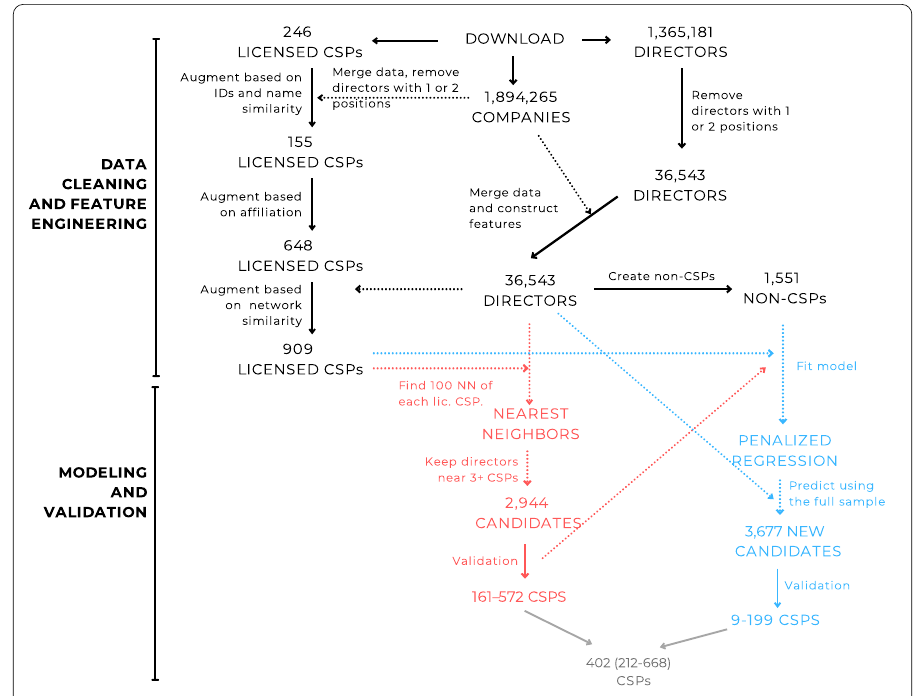
Figure 2 Flowchart with our approach, consisting of two phases. (i) The data cleaning and feature engineering phase (top part, in black). We started by downloading the datasets on licensed CSPs, companies, and directors. Directors (right branch) with one or two positions are excluded, and the remaining 36,543 directors are merged with company data to construct the network features. Licensed CSPs (left branch) are augmented using company data to reach a final set of 909 licensed CSPs. (ii) The modeling and validation phase (bottom part, in color). First, we use the nearest neighbors algorithm to find similar directors to the 909 licensed CSPs (red branch). We kept all directors that were within the 100 closest directors to at least three licensed CSPs. We manually validated 100 of them to estimate the size of the illegal CSP industry at 161–572 entities. Second, we conducted a validation test using penalized logistic regression (blue branch). We found 3677 new potential candidates and manually validated 100 of them to estimate that the first approach